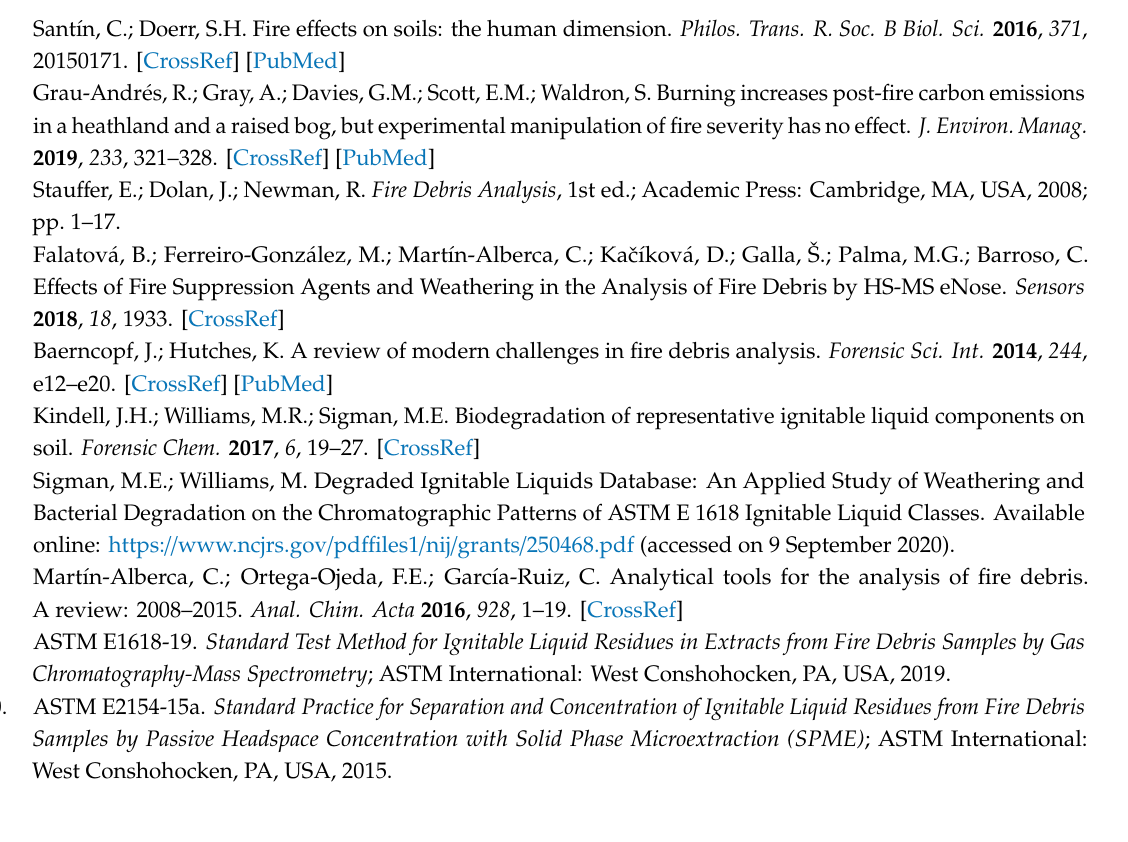
Figure S1: Dendrogram resulting from the analysis (M 50 × 990 ). Values at branches are AU p -values (left), BP values (right), and cluster labels (bottom). Clusters with AU ≥ 95 are indicated by the